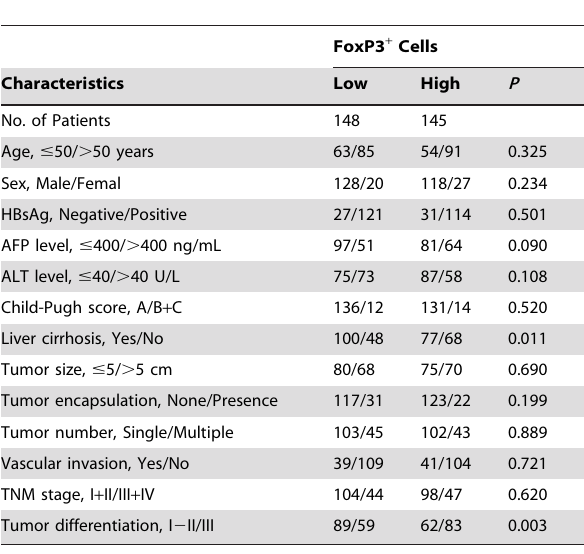
Table 1. Correlation between tumor FoxP3 + cell and clinicopathologic characteristics.